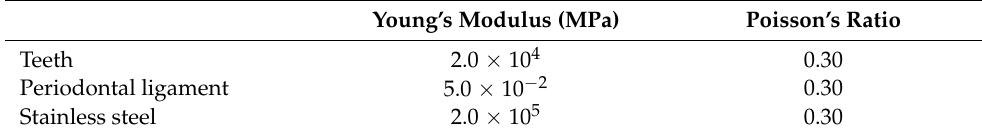
Table 1. Common material properties.